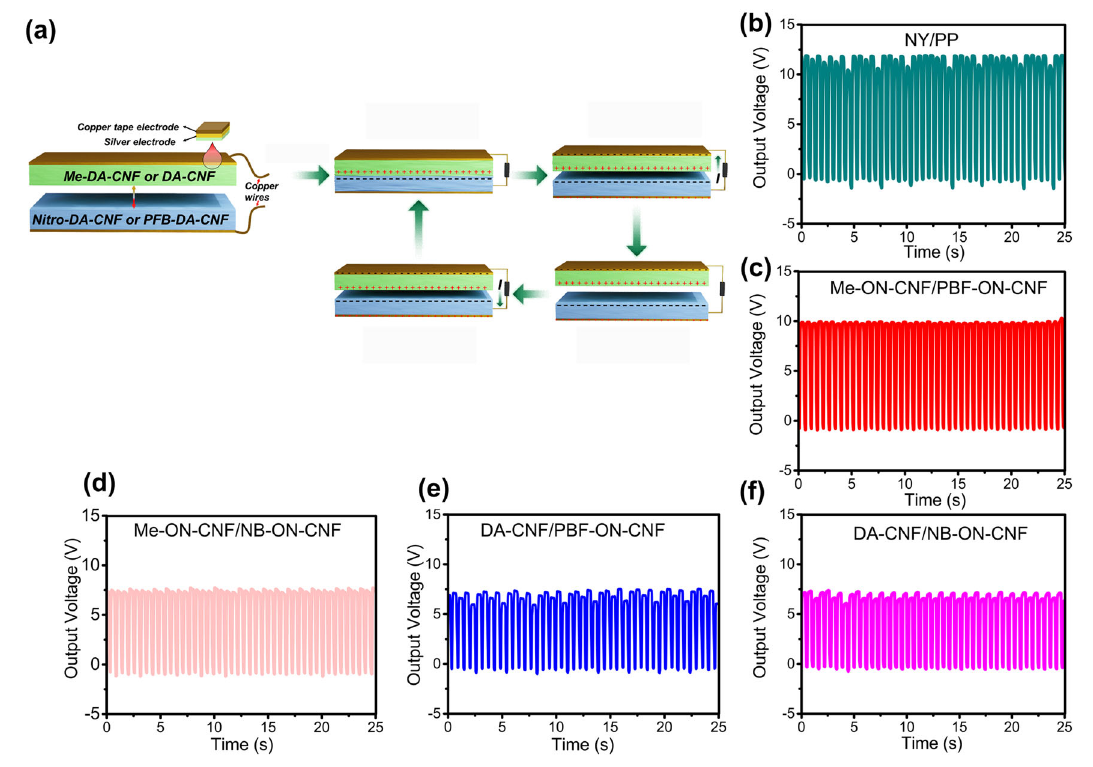
Fig. 7 | Triboelectric properties of DA-CNF and R-ON-DA-CNF fi lms. a Working mechanism of TENG. b Output voltage of PP/NY pair. c Output voltage of Me-ON-